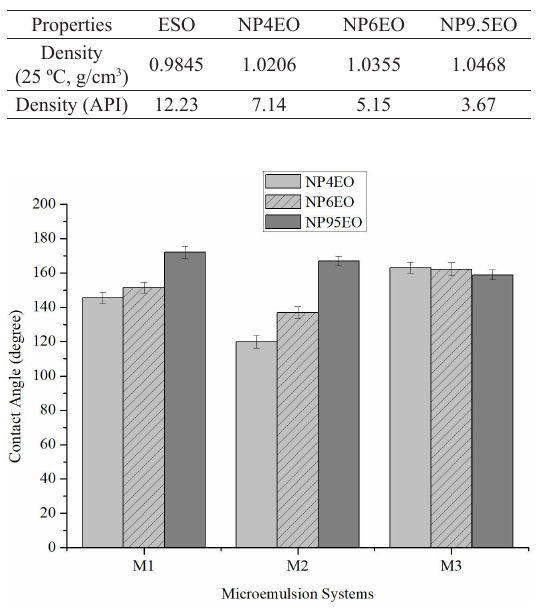
Table 6. Density of ESO and surfactants (NP4EO, NP6EO and NP9.5EO).